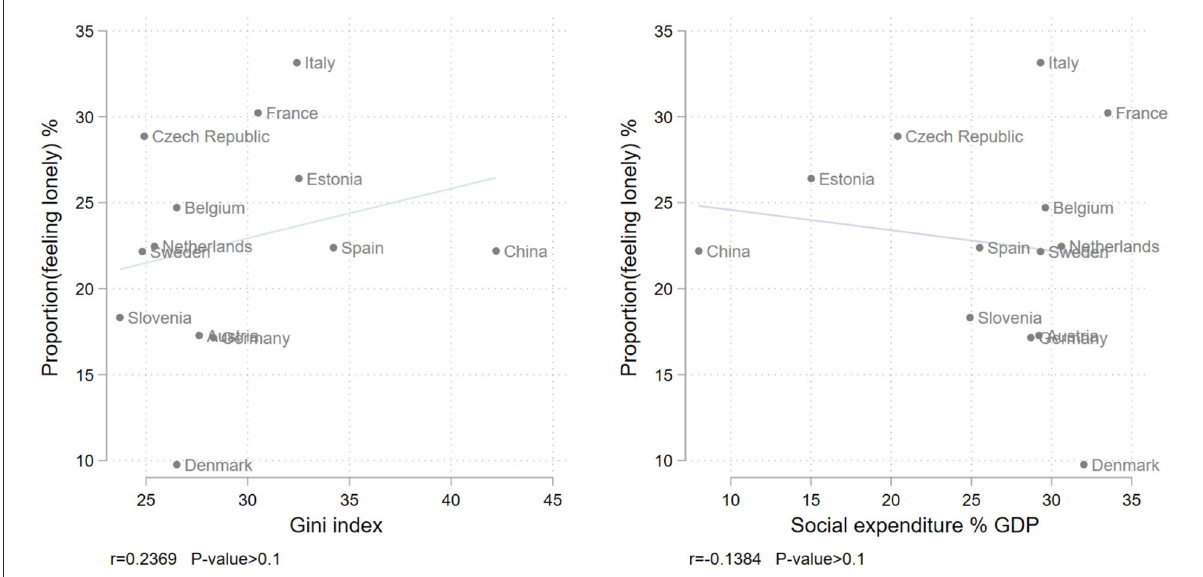
FIGURE1 Gini index, social expenditure as percentage of GDP, and prevalence of loneliness by country.